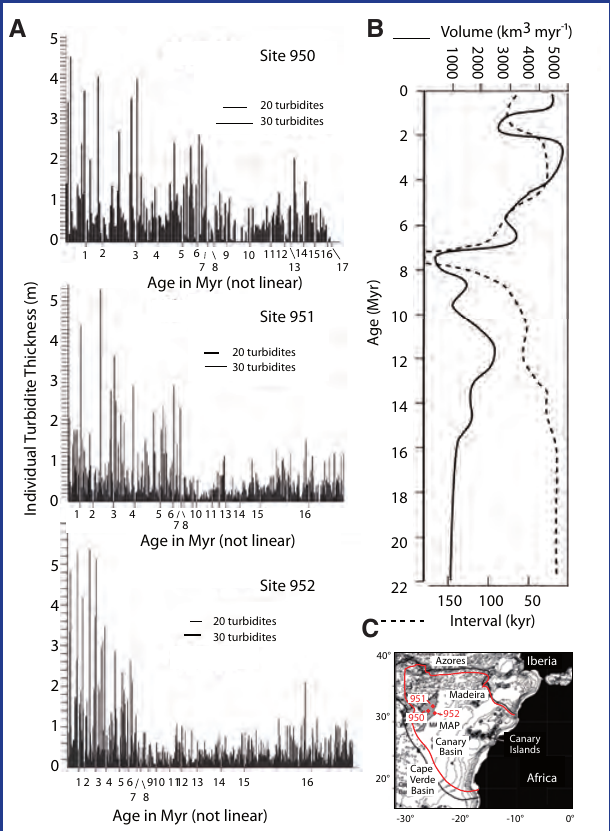
(cid:42)(cid:79)(cid:1)(cid:84)(cid:74)(cid:85)(cid:86) Properties & Processes - Document physical properties - Constrain shear strength/rheology - Monitor pore pressures, etc. - Compare failed and unfailed regions Shipbased Coring & Logging Borehole Installations Cabled Instrument Arrays Loading Precursory Phenomena, e.g. - Fluid transients, etc. - Seafloor deformation - Physical properties changes - Microseismicity Figure 14. Schematic diagram of ocean drilling and borehole observatories to sample and measure in situ physical properties and mechanical state, and monitor transient phenomena that may be precursory to failure in actively deforming regions.